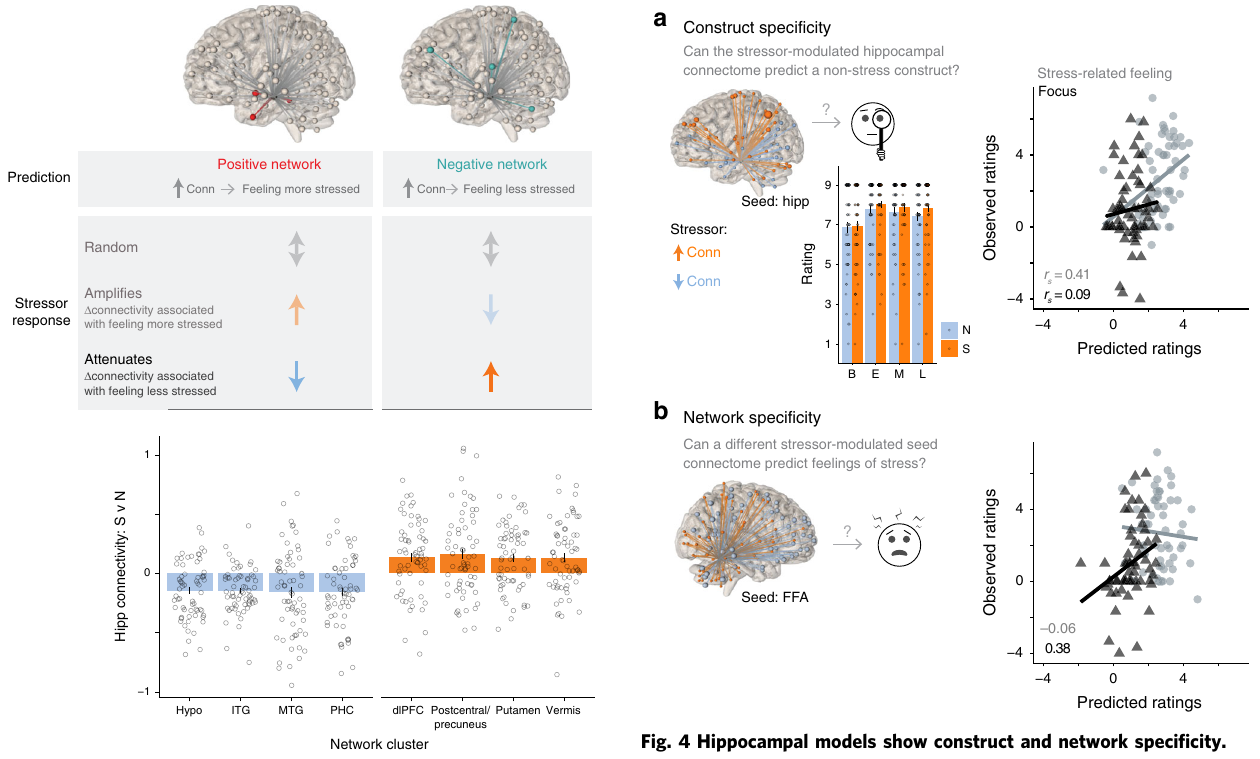
signi fi cantly out-performed models trained on the FFA network (Supplementary Fig. 2). Interestingly, the FFA network — speci fi cally, connectivity between FFA and clusters in orbito- frontal cortex (OFC) — could successfully predict focus (nonpara- metric P = 0.03; focus vs. stress: Z = 2.47, p = 0.013). Thus, this analysis revealed a double-dissociation: stressor-modulated hip- pocampal connectivity predicted feelings of stress (not focus), whereas stressor-modulated FFA connectivity predicted focus (not feelings of stress). Together, these results support the construct and network speci fi city of the hippocampal models. Further analyses con fi rmed that hippocampal model predic- tions were not confounded by age or motion. Motion, measured